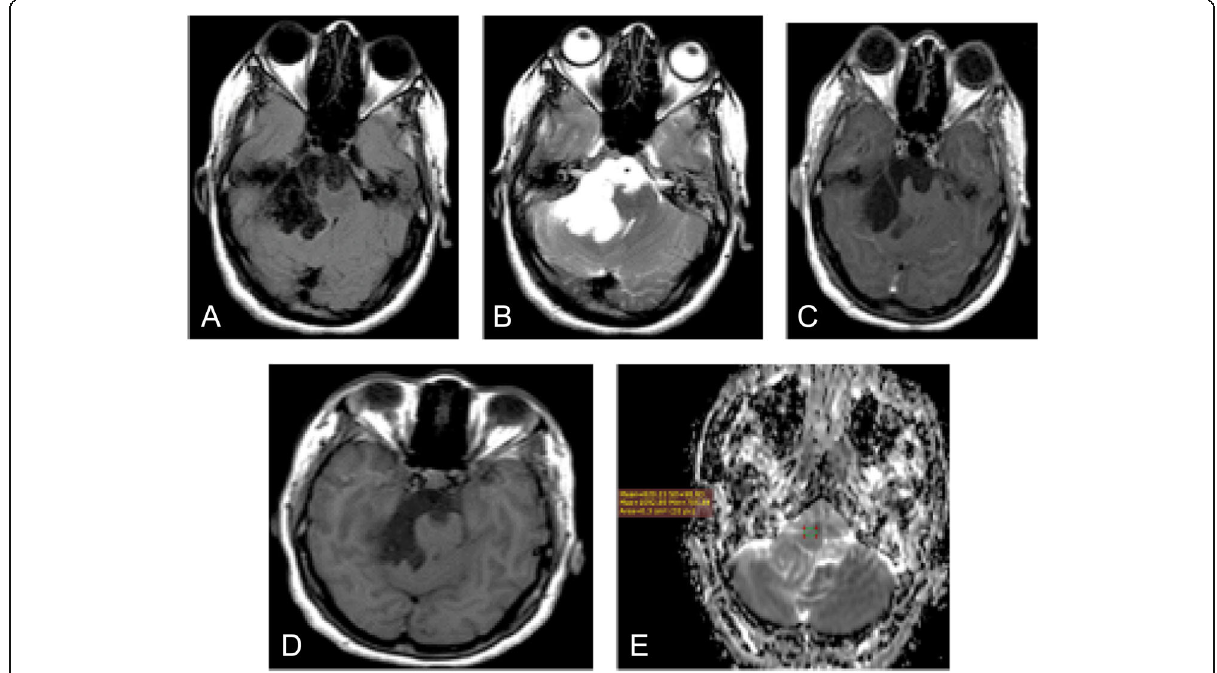
Fig. 5 Epidermoid cyst in 38-year-old male complaining from auditory problems. A lobulated extra-axial cystic lesion is seen in the right cerebellopontine angle (CPA) insinuating itself, compressing the pons, extending into prepontine cistern, and encasing the basilar artery. It displays low T1WI signal intensity ( a ) and high T2WI signal intensity cerebrospinal fluid (CSF) like ( b ). On FLAIR, it shows low SI (partially suppressed SI ( c ). It shows faint marginal enhancement on post-contrast study ( d ). It shows iso SI-like brain parenchyma (restricted diffusion); it does not have high CSF SI-like arachnoid cyst ( e